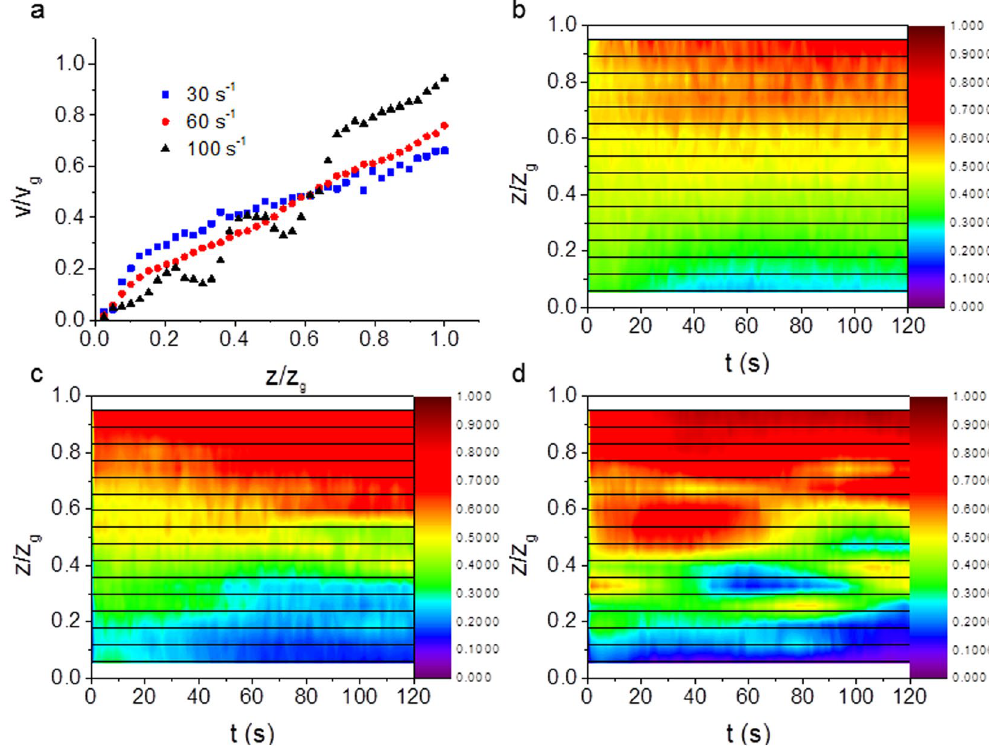
Figure 2. ( a ) Normalized shear velocity ( v / v g ) as a function of normalized distance across the rheometer gap ( z / z g ) for a 15 mg/ml solution of DNA (high salt) at three different steady shear rates that show significant wall slip, bulk strain localization and irregular flow when sheared at 100 s − 1 . Strain localization is also observed on the boundaries, but it decreases with shear rate. The colour maps show the normalized shear velocity as a function of the normalized distance across the rheometer gap, for the same sample and the time after shear start-up ( τ ), at constant shear rates of ( b ) 50 s − 1 , ( c ) 60 s − 1 and ( d ) 100 s − 1 . The horizontal lines show the depths at which measurements were made, and the colour scale is normalized to the top plate velocity.